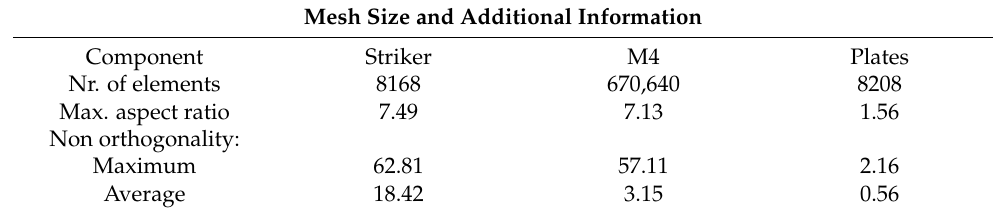
Table 6. Relevant quality parameters of the used meshes.